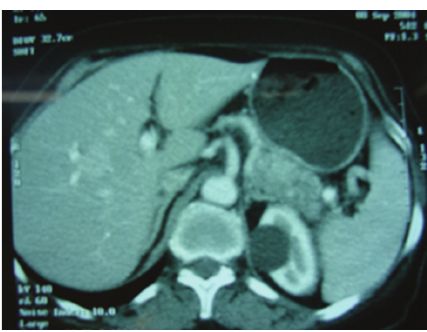
Figure 4: Hypervascular tumor in the tail of pancreas with metas- tases in segment V of the liver.